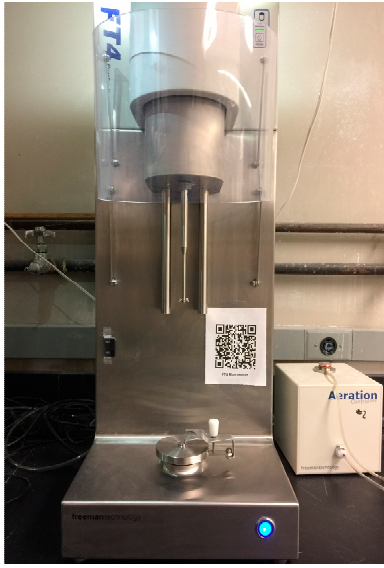
Figure 7. FT4 powder rheometer.